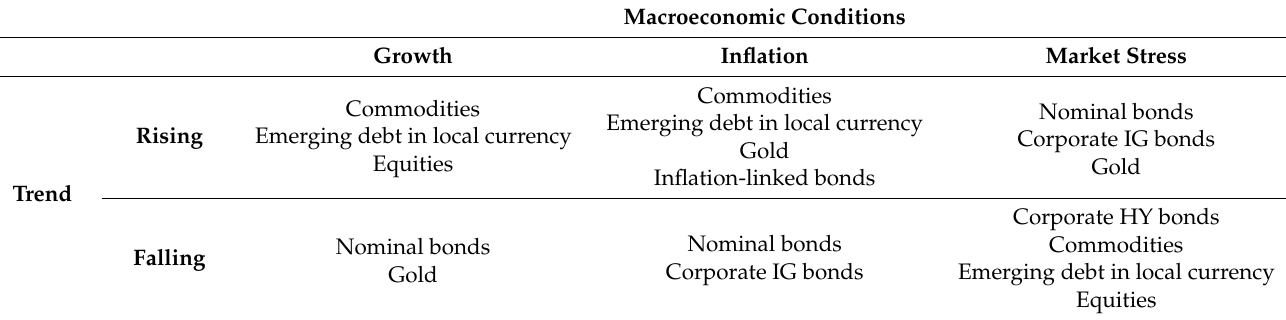
Table 1. Relation between the asset classes, trends, and macroeconomic